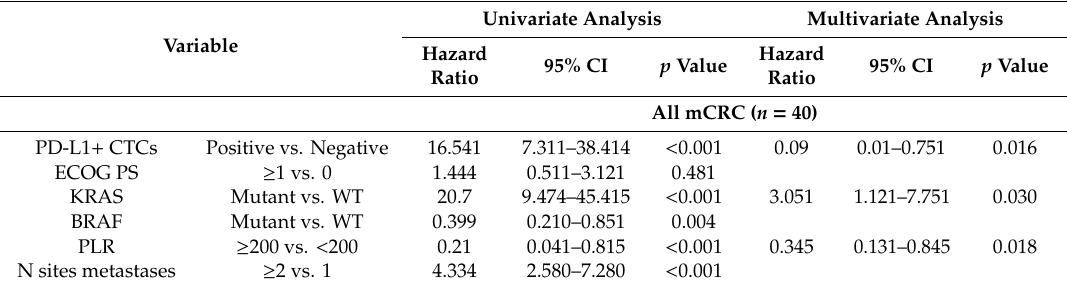
Table 2. Univariate and Multivariate Cox regression